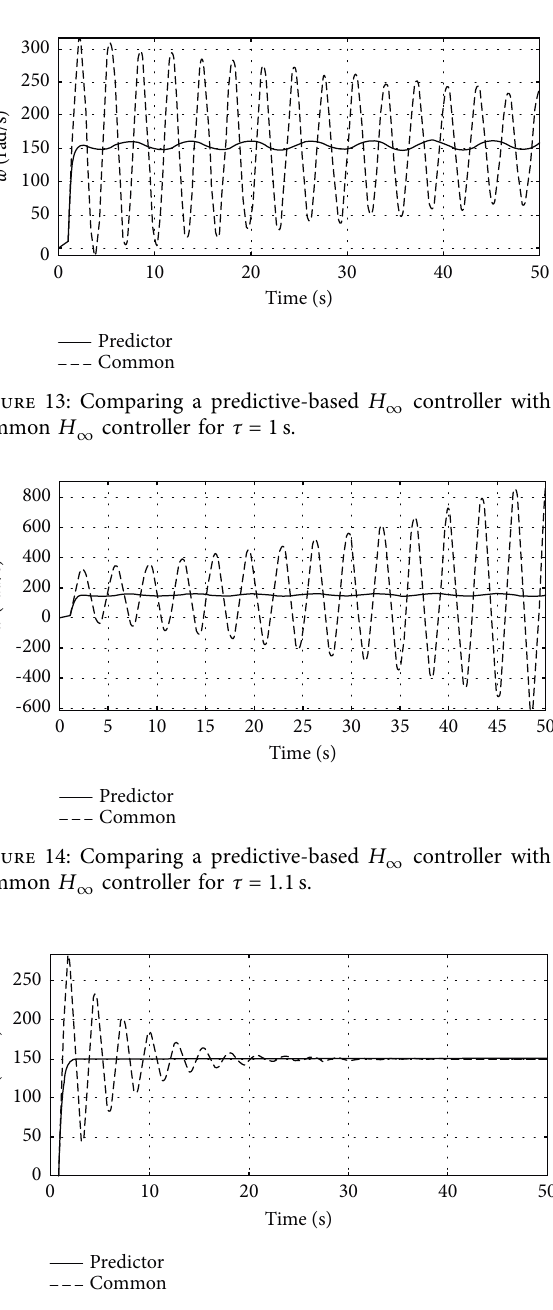
controller with a ∞